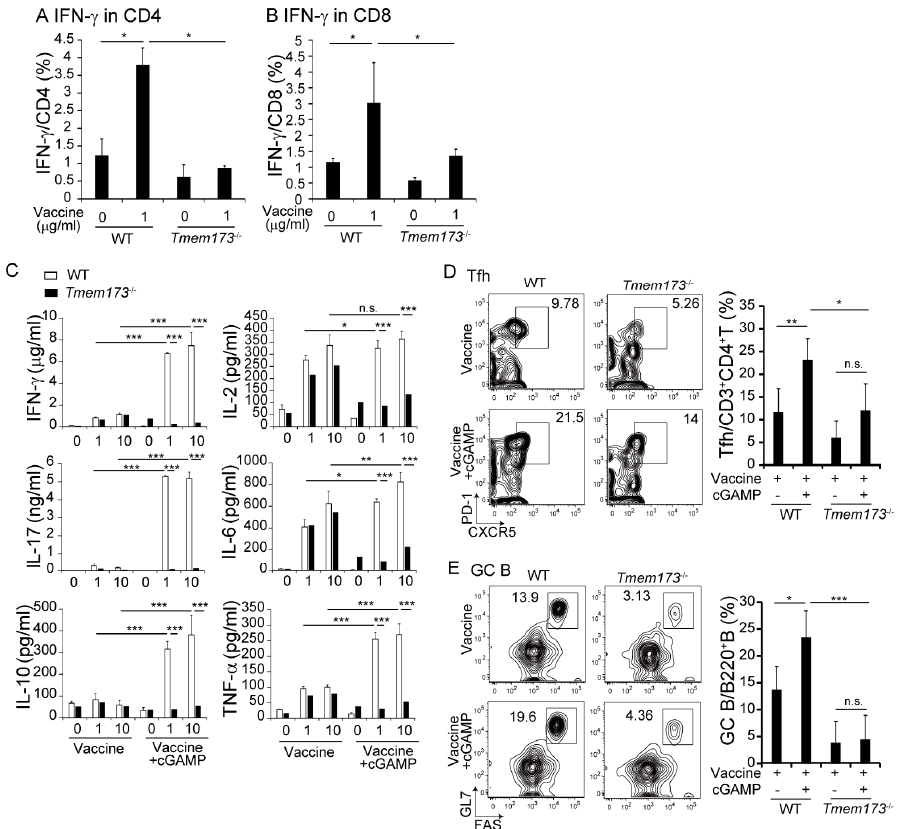
Figure 4. cGAMP augments cytokine production and T-cell responses in a STING-dependent manner. WT mice were i.n. vaccinated twice and splenocytes (1 × 10 6 cells) were re-stimulated by 0–10 µg/mL of split-HA vaccine for 3 days. Cells were incubated with brefeldin A during the last 6 h of culturing and stained with PE-Cy7-labeled anti-CD3, FITC-labeled anti-CD4, PE-labeled anti-CD8, and APC-labeled anti-IFN- γ Abs. The percentages of IFN- γ -producing CD3 + CD4 + T-cells and CD3 + CD8 + T-cells are shown in ( A , B ). ( C ) The levels of IFN- γ , IL-2, IL-6, IL-10, IL-17, and TNF- α production in culture supernatants were determined by CBA assay. The values are presented as the mean ± SD of 3 samples for each group. ( D ) Flow cytometry profiles of NALT germinal center (GC) B-cells. GC B-cells were stained with APC-labeled anti-CD45, PE-Cy7-labeled anti-Fas, peridinin-chlorophyll protein (PerCP) Cy5.5-labeled anti-GL7, and FITC-labeled anti-B220 Abs 2 weeks after vaccination. One representative experiment out of four is shown. The graph shows the percentage of GC B cells. ( E ) Flow cytometry of NALT T follicular helper (Tfh) cells stained for APC-labeled anti-programmed cell death (anti-PD)-1, PE-Cy7-labeled anti-CD3, PerCP-Cy5.5-labeled anti-CXCR5, Alexa700-labeled anti-CD45, and FITC-labeled anti-CD4 Abs 2 weeks after vaccination. One representative experiment out of four is shown. The graph shows the percentage of Tfh cells. The values are presented as the mean ± SD of 4 mice for each group. * p < 0.05; ** p < 0.01; *** p < 0.001 and n.s.: not significant in the Mann-Whitney U test. The indicated numbers show the percentages of gated populations.